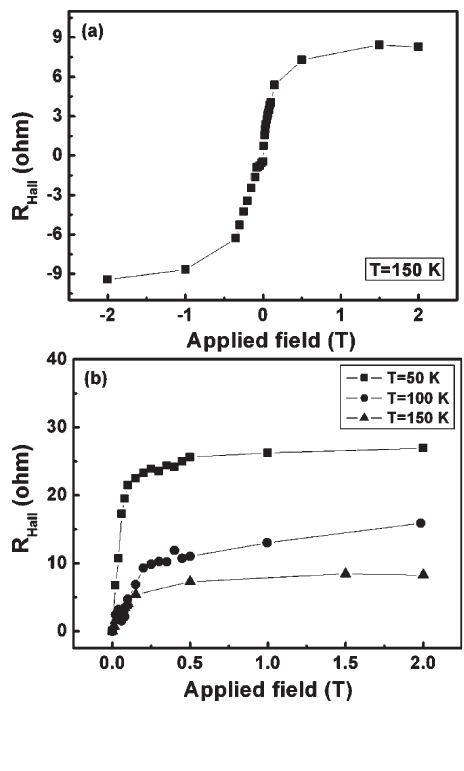
Figure 21 . The whole Hall resistance vs . field of an a-Si 150 K. (b) Collective Hall resistance: Hall vs field curves of an a-Si sample measured at 50, 100, and 150 K, respectively. (Reprinted with permission from Ref. [81]. Copyright 2009, American Institute of